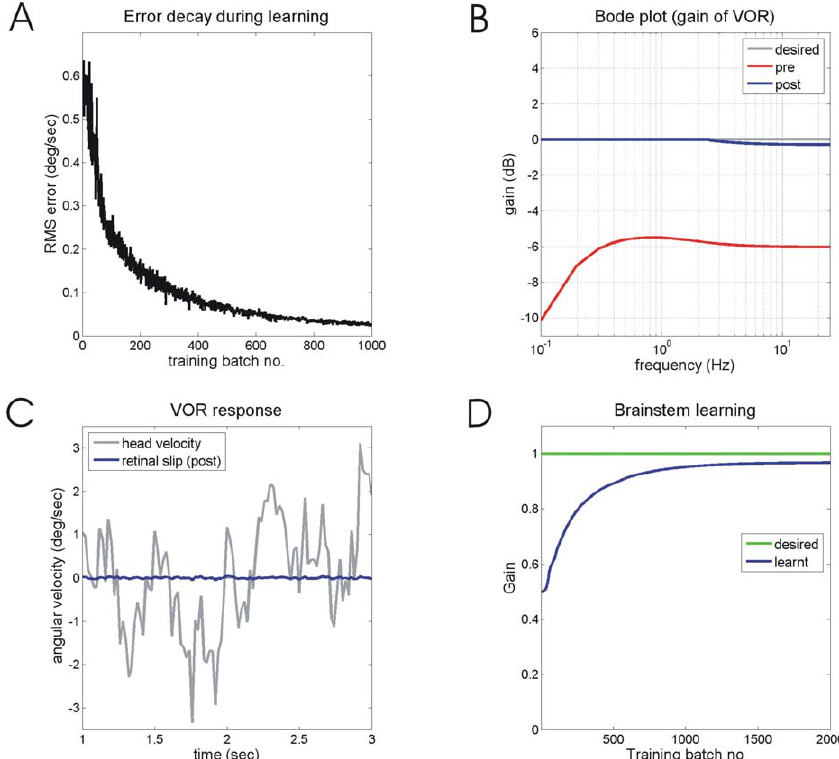
Figure 7. VOR Calibration with a Second Site of Plasticity in the Brainstem (A) Learning as measured by retinal slip error. (B) Bode gain of system before and after learning. (C) Retinal slip in response to colored-noise head velocity before and after learning. (D) Change in gain of brainstem as learning